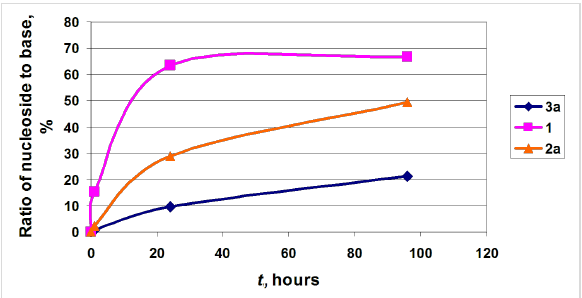
Figure 4: Progress of the formation of 9-(2-deoxy-2-fluoro- β -D-arabi- nofuranosyl)-2-chloroadenine ( 1 ), 2-amino-9-(2-deoxy-2-fluoro- β -D- arabinofuranosyl)adenine ( 2a ) and 9-(2-deoxy-2-fluoro- β -D-arabinofu- ranosyl)hypoxanthine ( 3a ) (Reaction conditions are shown in Table 1).